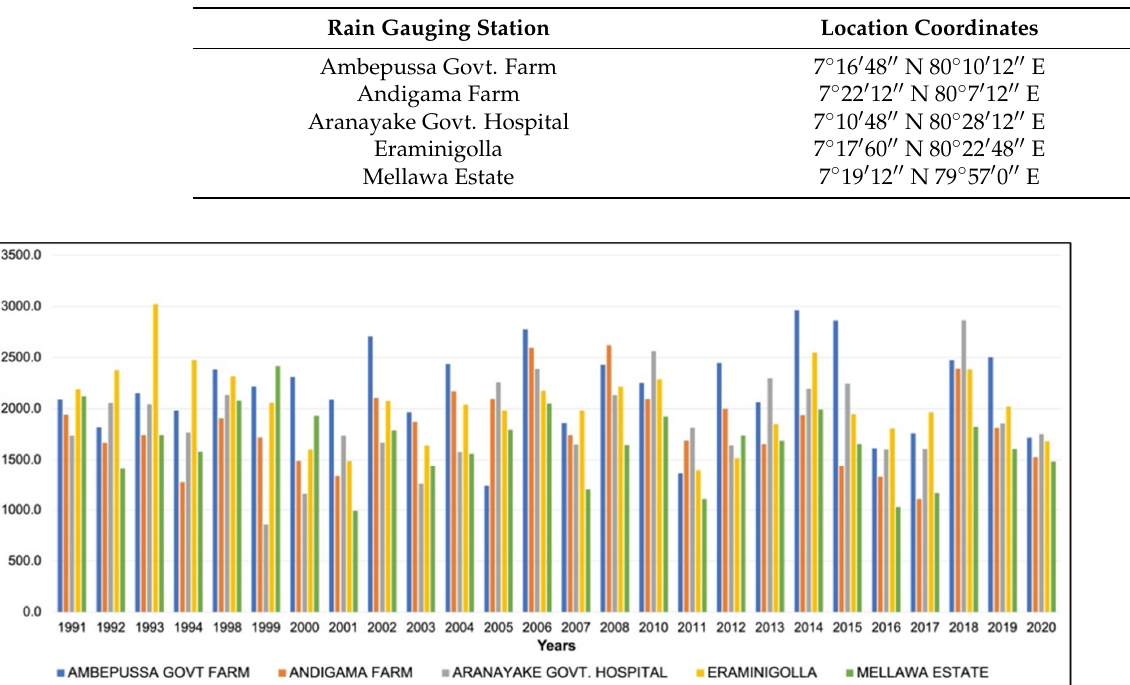
Figure 3. Map of soil types in Maha Oya River Basin.